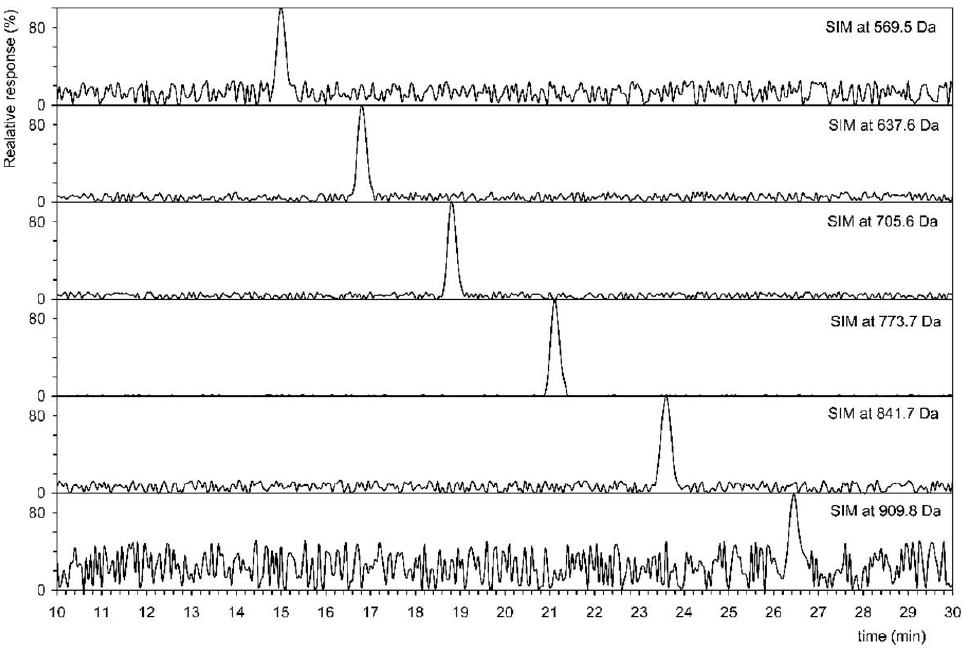
Figure 2. Selected ion monitoring (SIM) indicative of six homologs of polyprenols from C40 (569.5 Da) to C65 (909.8 Da) in Geobacillus stearothermophilus